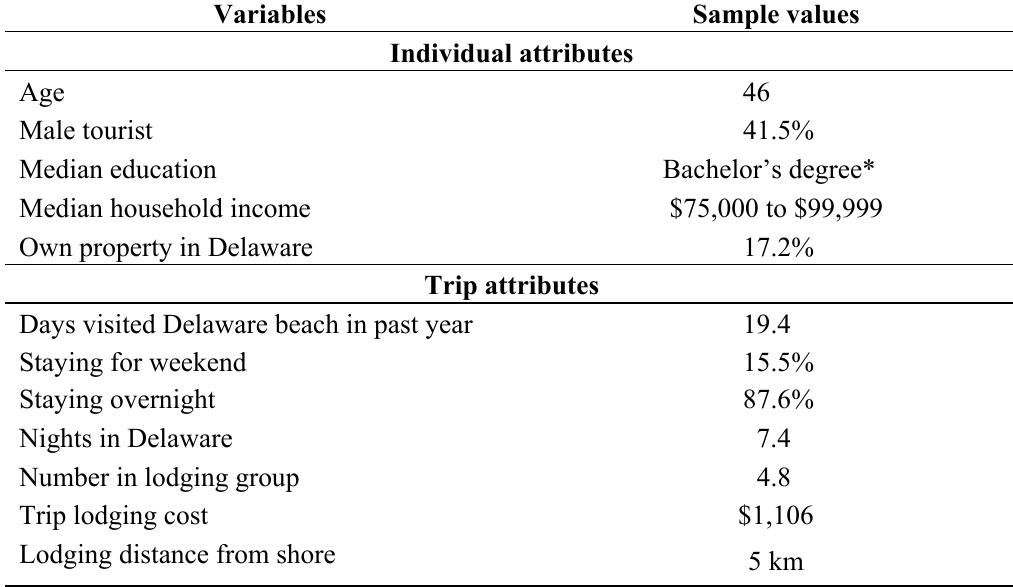
Table 2. Sample characteristics (means, unless indicated